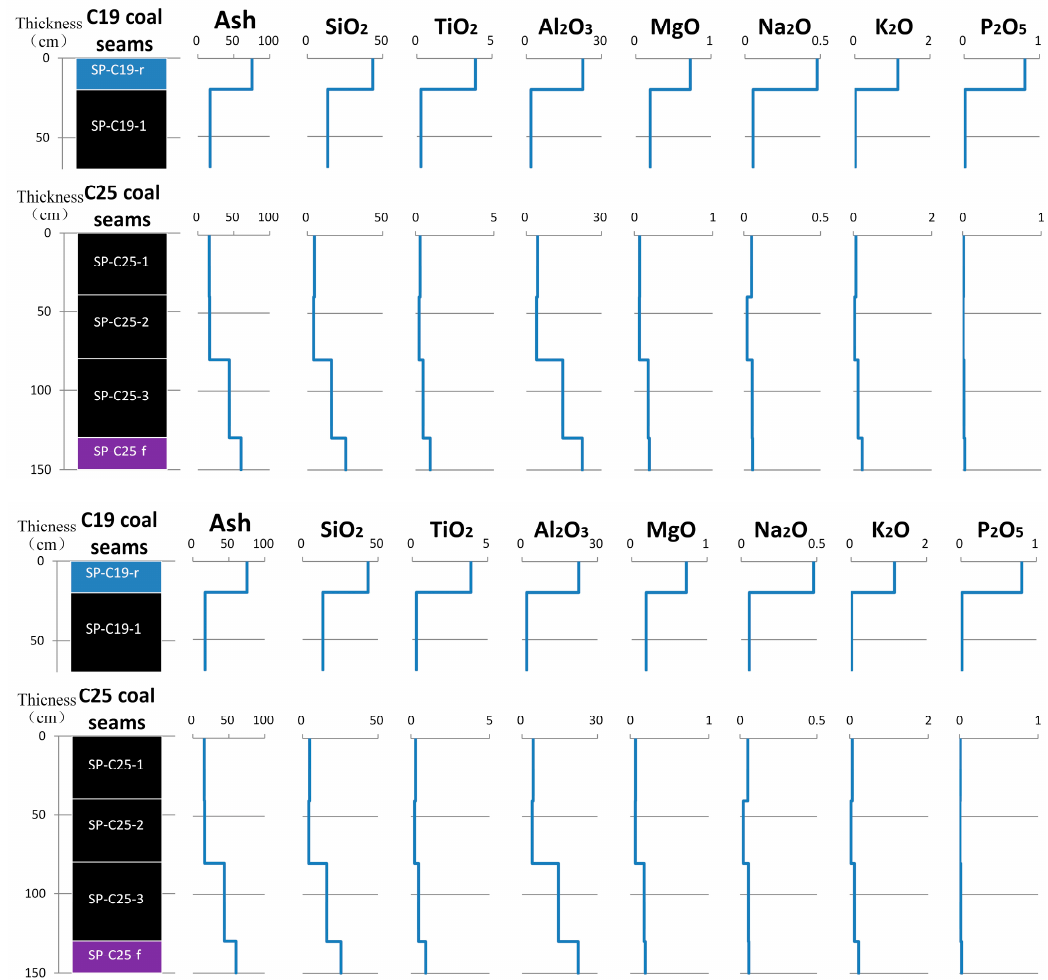
Figure 11. Variations of ash yield and selected major elements (%) through the roof, coal seam,